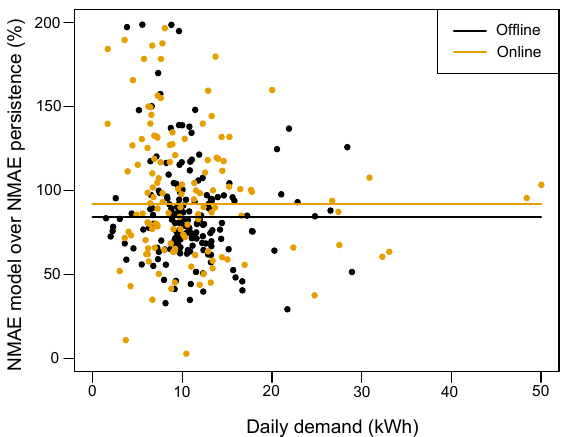
Figure 7. Each point represents the forecasting performance computed over a single household and single day. The NMAE ratio between our model and the persistence model (in %) is on the y -axis, and the total daily demand (in kWh) is on the x -axis. The horizontal lines represent the average performance over all households and all